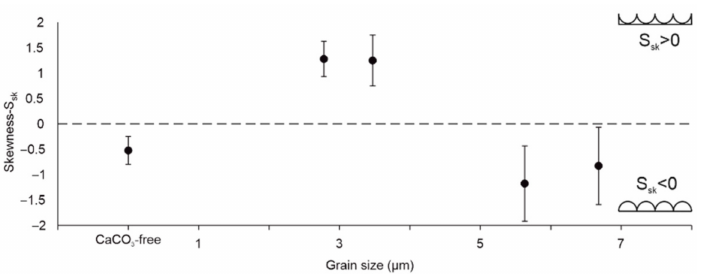
Figure 10. Skewness values S sk versus grain size of CaCO 3 particles for scratch surfaces after the scratch test. Simple graphics showing surfaces with positive and negative S sk values are